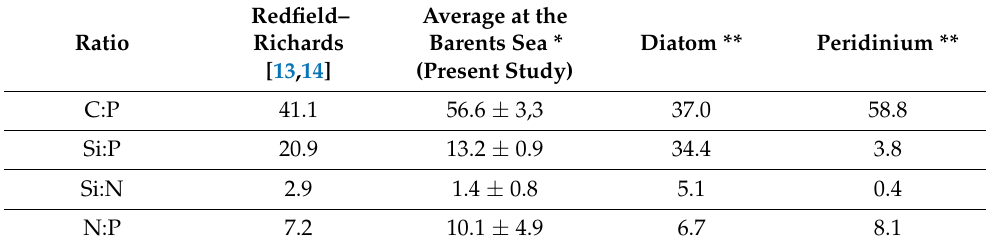
Table 5. Nutrient ratios and their content in different area and species (by mass).